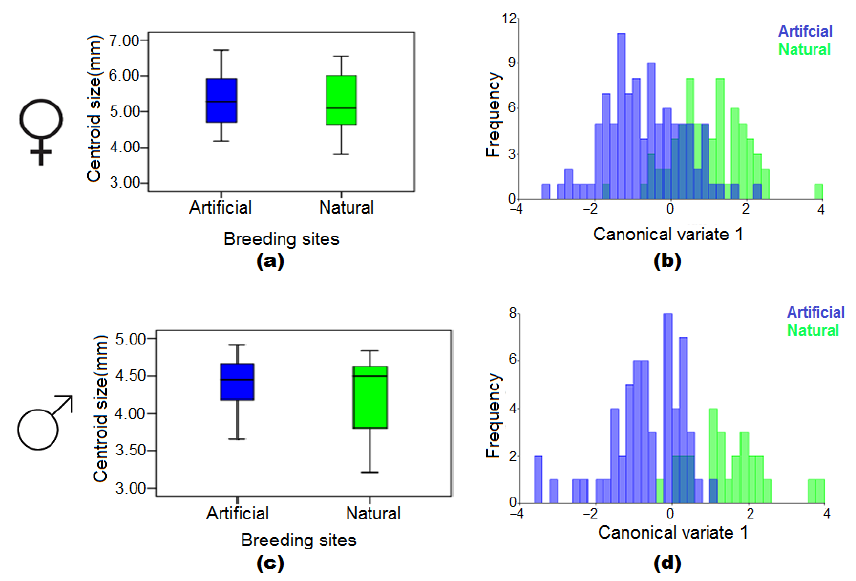
Figure 5. Box plots of wing centroid size and wing shape diagram of the first canonical variable between natural and artificial breeding sites in female ( a , b ) and male ( c , d ) Cs. longiareolata mosqui ‐ toes.